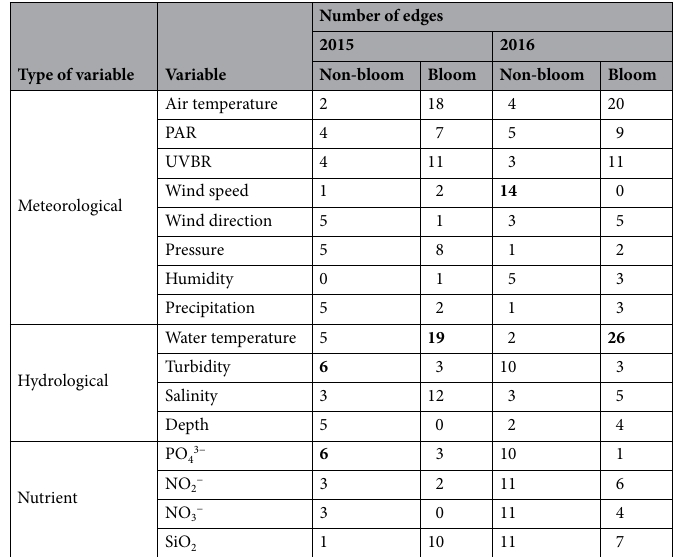
Table 2. Number of edges between the environmental factors and the plankton taxa in the bloom and non- bloom correlation networks of 2015 and 2016. Bold values emphasise the most correlated environmental factors for each